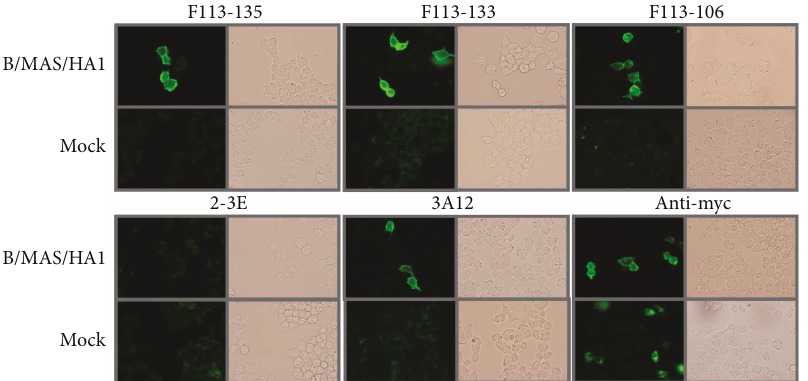
Figure 6: Immunostaining of cells that express HA1 molecule on the cell surface. Fab-PP form of Abs, F113-135 (type 1), F113-133 (type 1), and F113-106 (type 2) bound to HA1 expressed on the cell surface. Positive control: 3A12, anti-B/HA Ab, 2-3E (Fab-PP form), anti-rota VP4 Ab, anti-myc Ab for system check. Mock, pDisplay vector without insert was used for transfection.